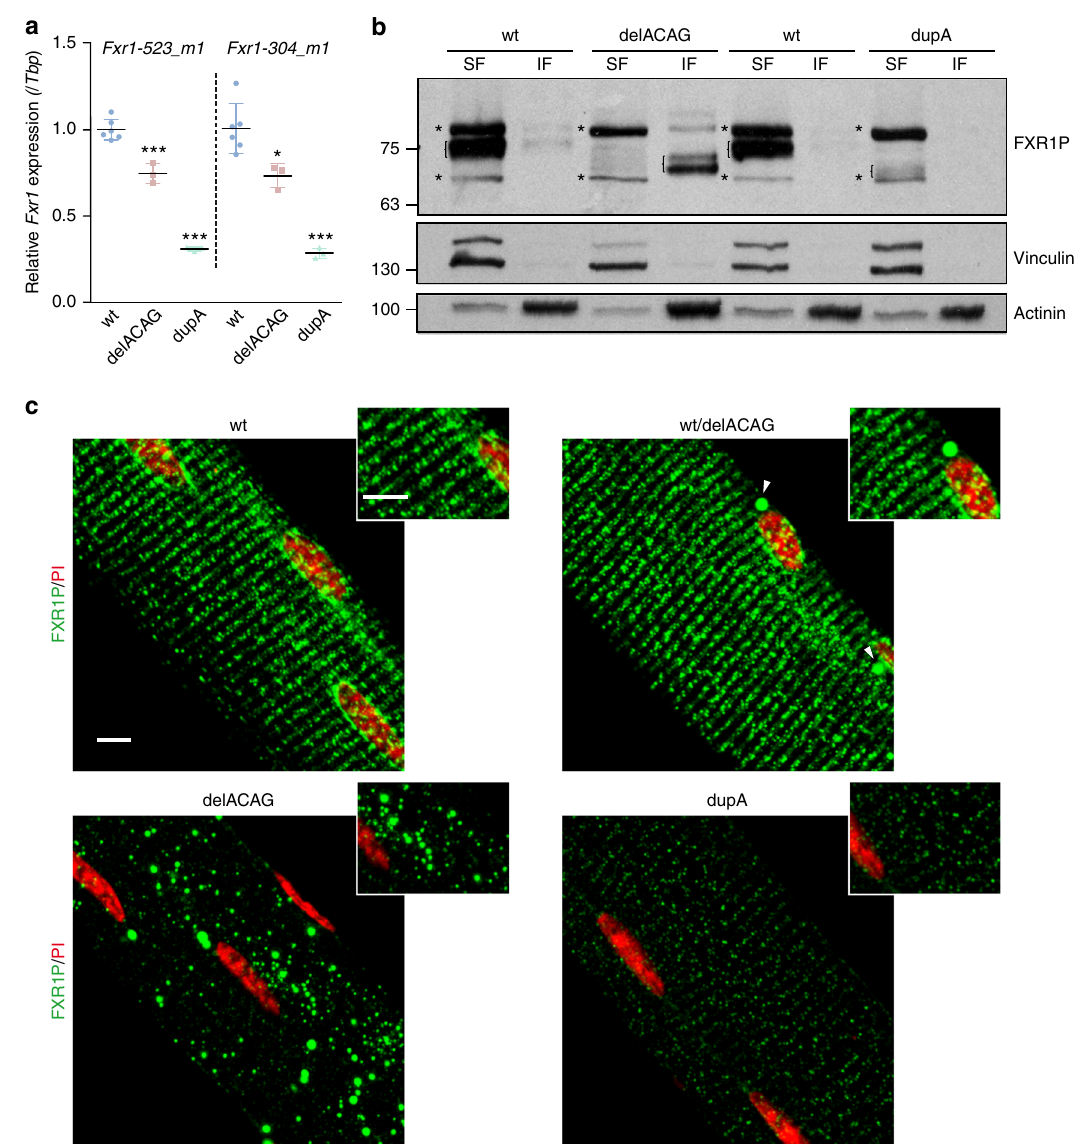
Fig. 5 Expression and subcellular localization of P82,84 isoforms in exon-15 mice. a Relative Fxr1 mRNA quanti fi cation in gastrocnemius of 2.5-months old mice by qRT-PCR using two different TaqMan probes: Fxr1-523_m1 (exons 2-3; Mm00484523_m1) and Fxr1-304_m1 (exons 14-15; Mm01286304_m1). Values are normalized to Tbp mRNA levels and represented as fold change of the mean value of wt mice. n = 6 (wt), 3(delACAG), 3(dupA). Data are mean ± s.d. followed by one-way ANOVA (***) with Tukey post-hoc test. b Representative FXR1P immunoblot of protein extracts from gastrocnemius (soluble (SF) and insoluble (IF) fractions) of delACAG and dupA mice and corresponding wt littermates. Vinculin and α -actinin were used as loading controls (2 – 3 months old mice, n = 4). Brackets denote isoforms e and f and non-speci fi c bands are labeled with asterisks. c Maximum Z-project and magni fi cation of confocal anti-FXR1P immuno fl uorescence images (green) in isolated EDL fi bers. n = 8(wt), 3(wt/delACAG), 8(delACAG), 6(dupA). Scale bars 5 µ m. FXR1P isoforms are localized in a striated pattern except in delACAG fi bers where are found predominantly in granules. Heterozygous wt/ delACAG fi bers contain a small number of granules (arrowheads) and the fl uorescent intensity of FXR1P is reduced in dupA mice. Nuclei are labeled with propidium iodide (PI,